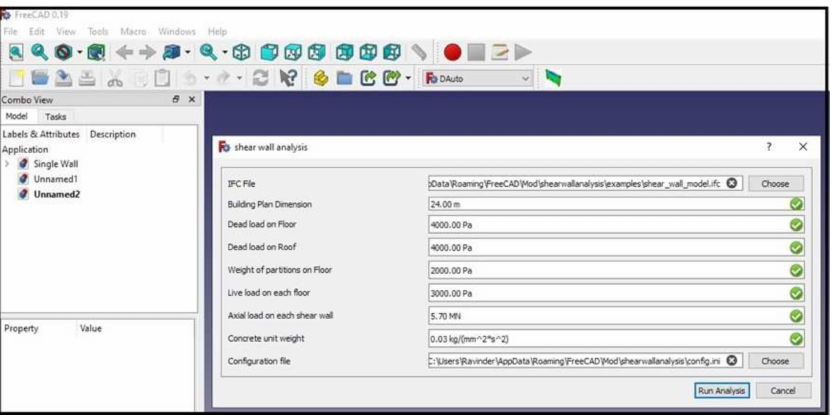
Figure 9. Main window of DAuto’s